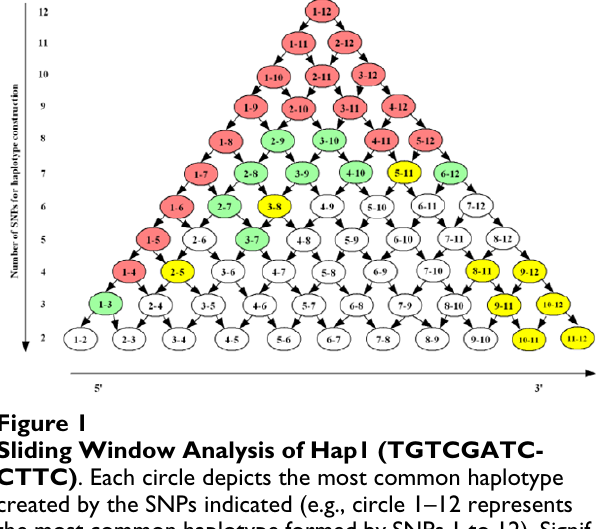
Table 6: Distribution of genotypes and allele frequencies at the ELN gene in the Caucasian cases and controls Locus Genotype Freq(q) Cases vs. Controls ( p -value)